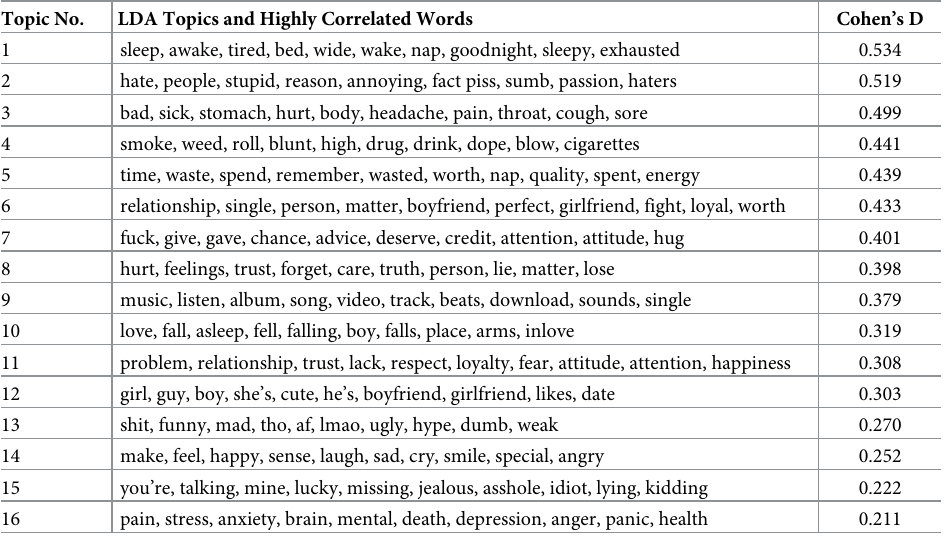
Table 10. Results from LDA analysis for female: 23—29. Topic No.